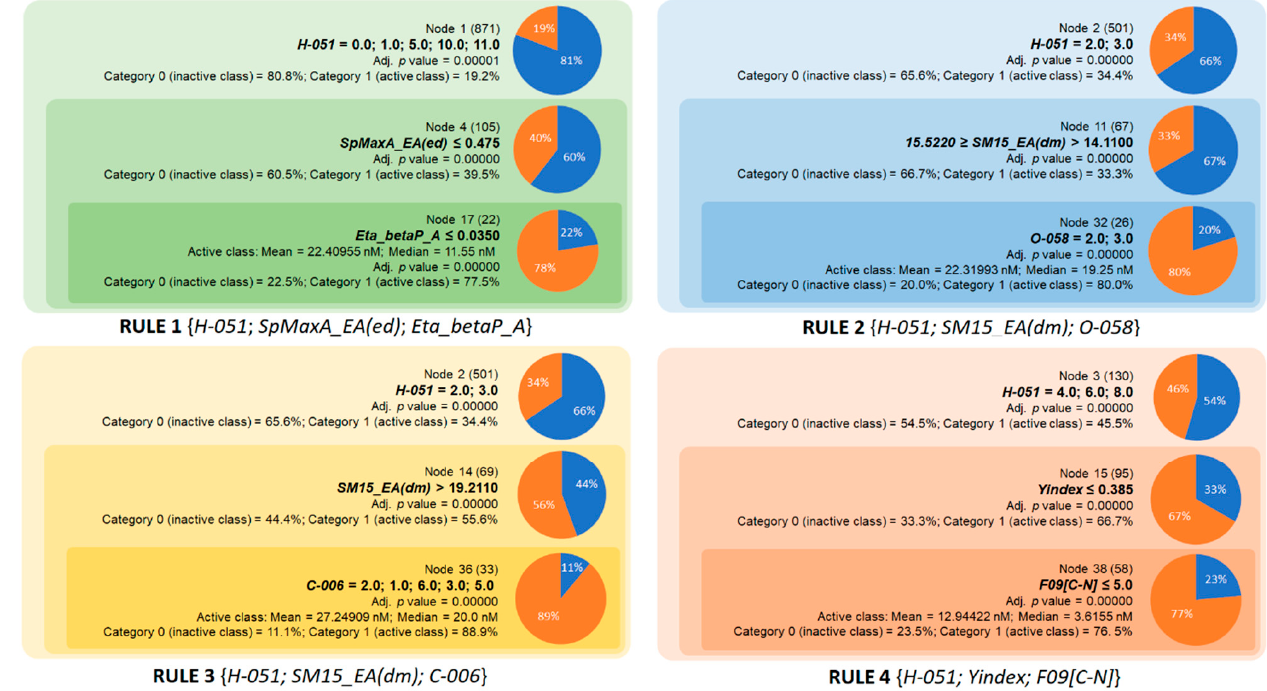
Figure 2. Overview of the four chemical rules elaborated in the current study and applied to predict AChE inhibition. Table 3. Molecular descriptors included in the four AChE rules.